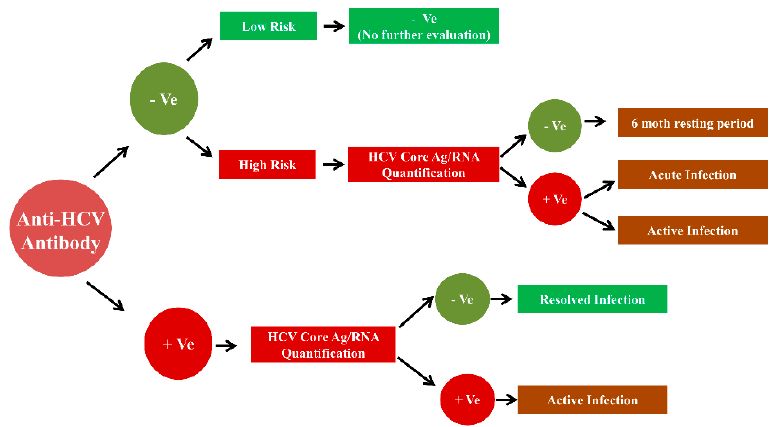
Figure 2. Algorithm for Hepatitis C screening.